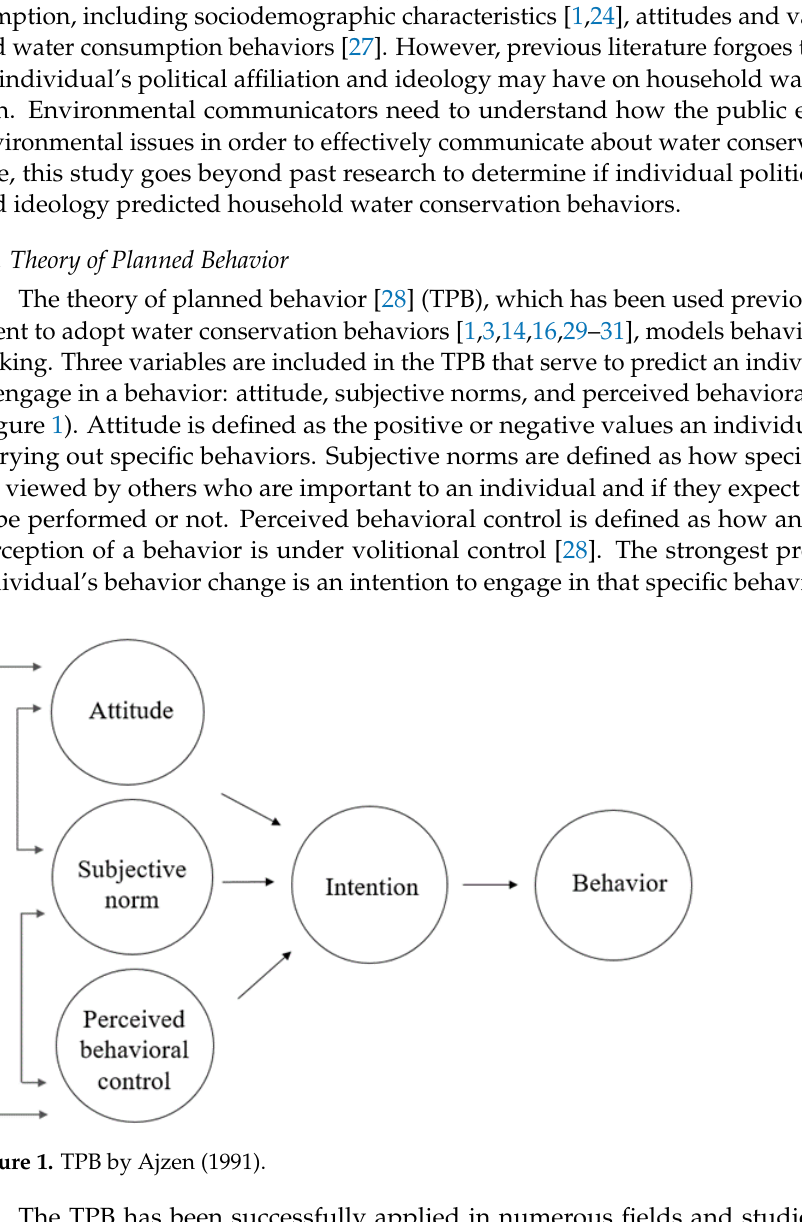
Figure 1. TPB by Ajzen